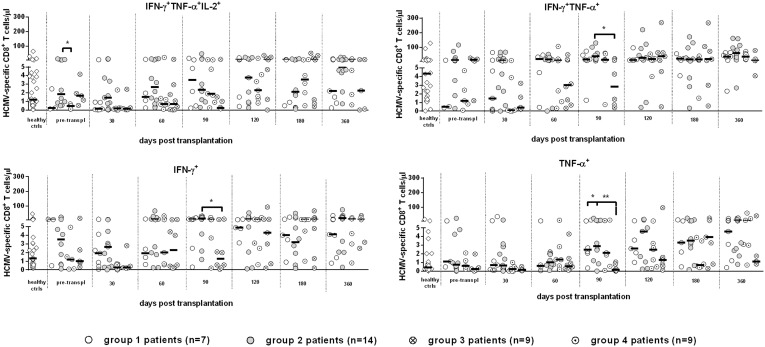
Kinetics of median levels of polyfunctional HCMV-specific CD8+ T-cells in groups 1–4 SOTR.No consistent statistically significant difference was observed between the four patient groups.